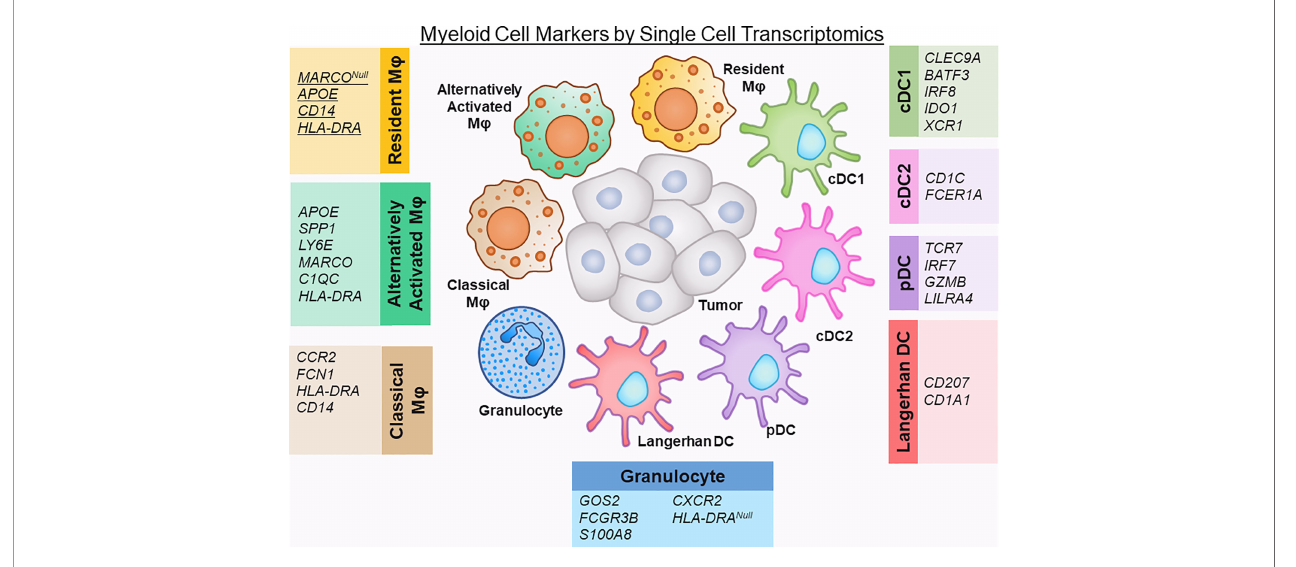
FIGURE 2 | De fi ning myeloid cell markers by single cell